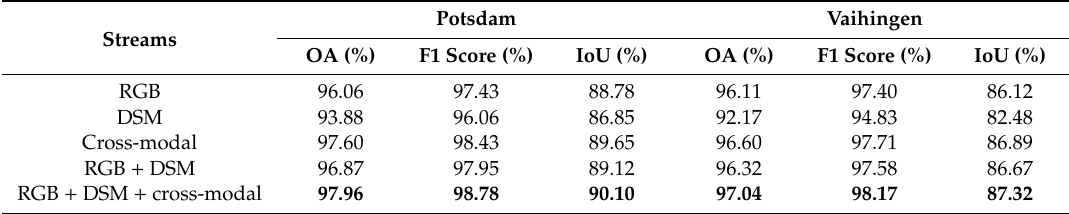
Table 3. Statistical results obtained from di ff erent streams. “Cross-modal stream” can also be seen as a feature-level fusion method. “RGB + DSM” denotes the decision-level fusion of RGB and DSM data. “RGB + DSM + cross-modal” denotes the proposed hybrid fusion